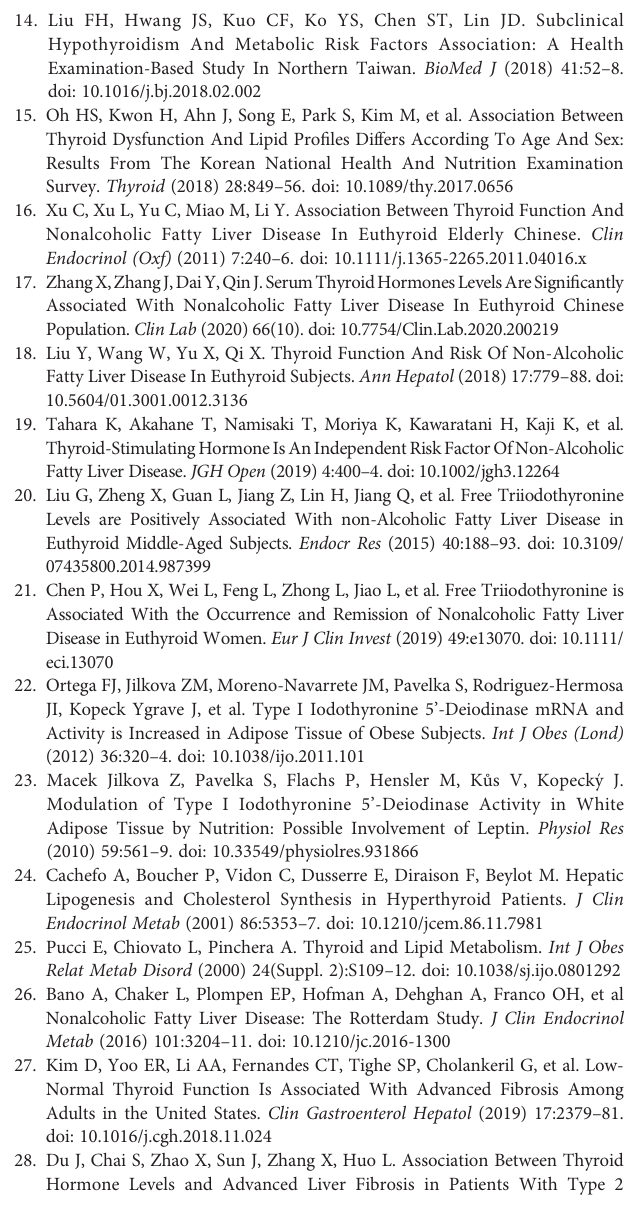
Supplementary Figure 1 | The association of FT3 levels with FAP value and LSM value. (A) . The association of FT3 levels with FAP value in all participants; (B) . The association of FT3 levels with LSM value in participants with